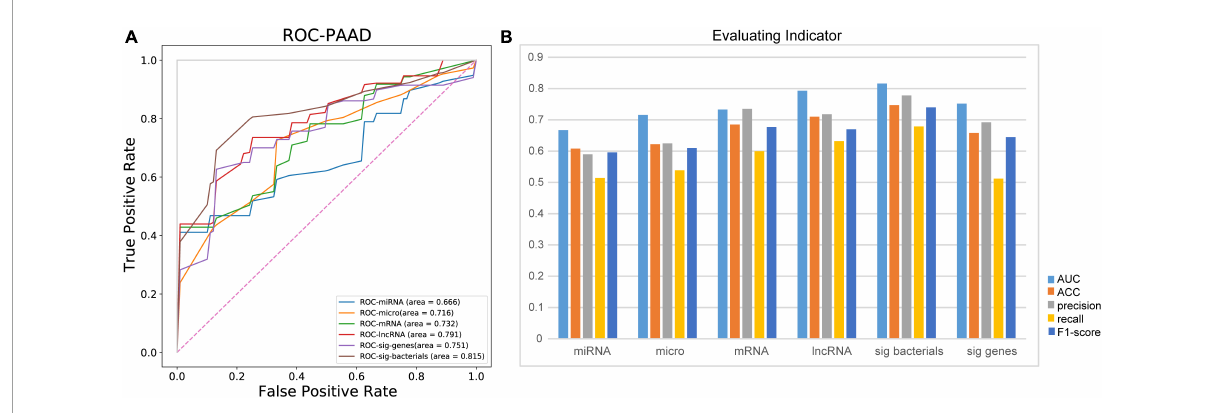
FIGURE5 Ten identified bacterial biomarkers perform best in predicting recurrence and metastasis in patients with PDAC. (A) Comparison of AUC in patients with recurrence and metastasis predicted by different omics. (B) Evaluation of predictive ability of different evaluation indices for recurrence and metastasis of PDAC patients; micro, microbiome; sig bacteria, 10 identified bacterial biomarkers; sig genes, identified DEGs from mRNA data; AUC, area under curve; ACC, accuracy.